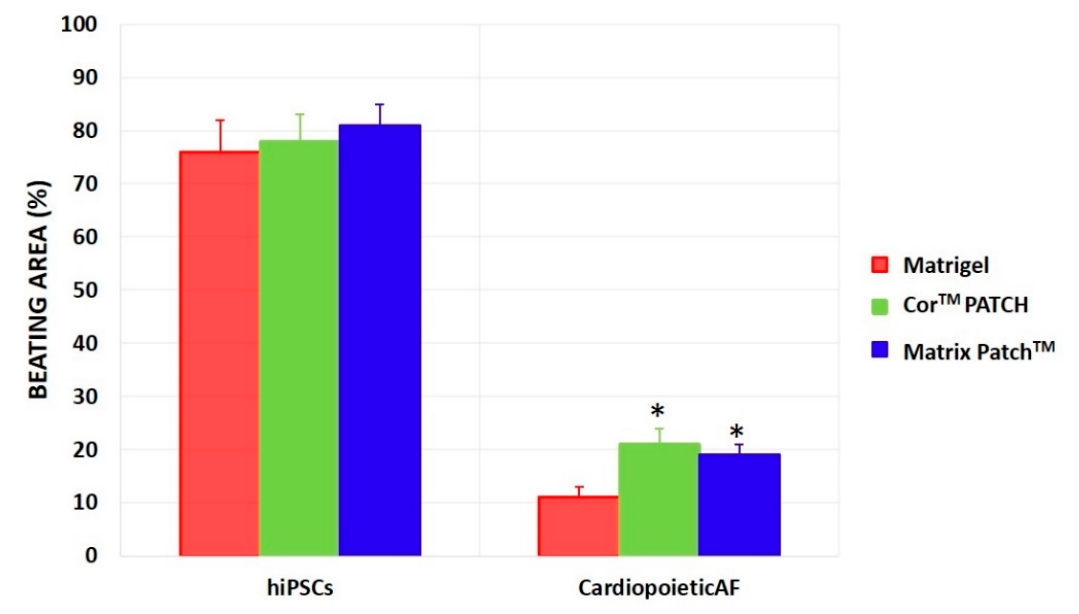
Figure 5. Percentage of dish area of hiPSC- and Cardiopoietic AF-derived CMs that presented spontaneous beating foci after 15 days of differentiation in Matrigel ® (red), Cor TM PATCH (green), or Matrix Patch TM (blue). hiPSC-derived CMs were lower compared to Cardiopoietic AF-derived CMs differentiated on the Cor TM PATCH and the Matrix Patch TM, compared to Matrigel ® . The graphs show the mean ± SD of five independent experiments; * indicates statistically differences ( p < 0.05) of the Cor TM PATCH or the Matrix Patch TM culture vs. the same cells cultured in Matrigel ® .